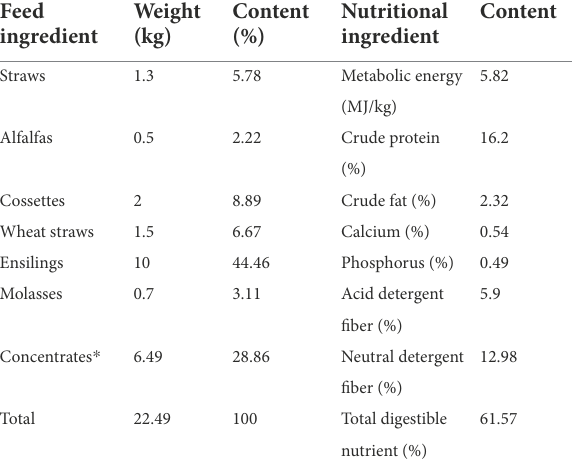
TABLE 1 Diet composition and nutrient levels (based on dry